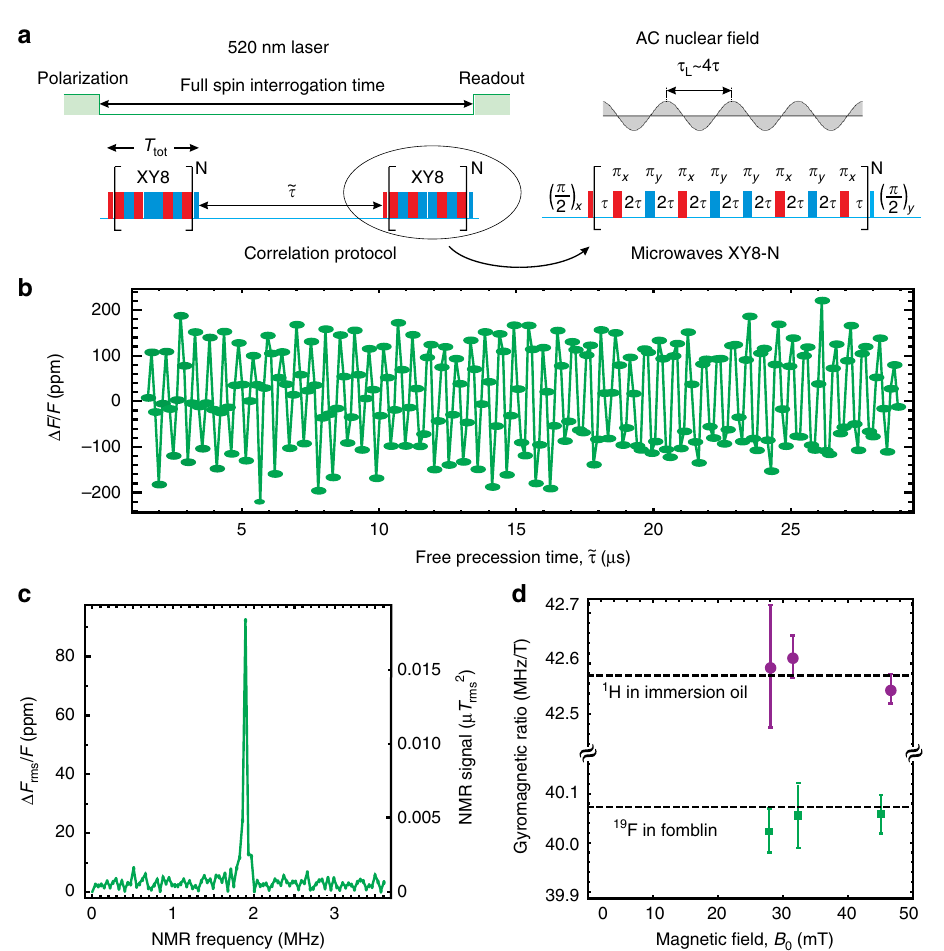
Fig. 3 Nanoscale NMR. a Sensing protocols: optical pulses are used to pump and probe NV spin state via the spin-dependent fl uorescence; microwave multipulse sequences are applied between optical pump and probe pulses. Red and blue color indicates different microwave phases, which are shifted relative to each other by 90°. NV centers are resonantly tuned to detect a particular nuclear species by setting 4 τ = τ L , where 2 τ is the separation between π -pulses and τ L is the nuclear precession period. In order to reject common-mode noise the sequences are repeated with the phase of the last shifted by 180°. The resulting signals are then subtracted and normalized to give the measurement results. b Time-domain NMR signal for 19 F nuclei in Fomblin ® oil taken using XY8-13 correlation sequence. c 19 F frequency-domain NMR signal at B 0 = 47.1 mT obtained by Fourier transform of the data in b . d Measured 1 H and 19 F gyromagnetic ratios at different B 0 values. Dashed lines are literature values 51 . Error bars represent standard error of the